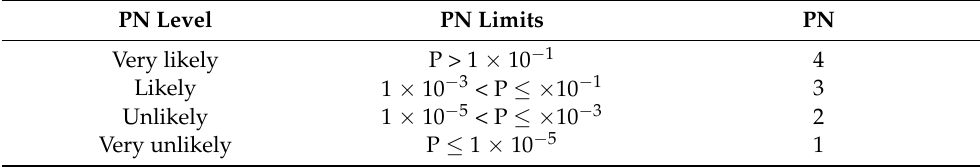
Table 2. Probability levels, limits and